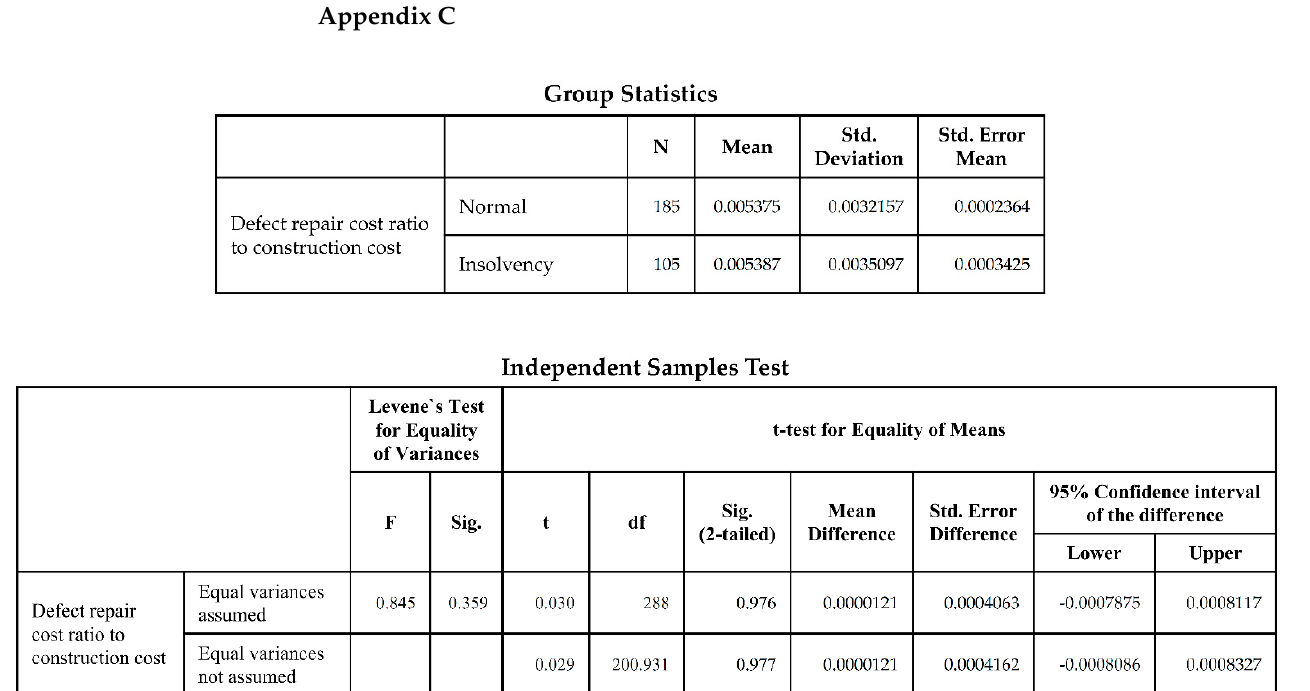
Figure A5. t -test result of building contract. Figure A5. t ‐ test result of building contract. Figure A5. t ‐ test result of building contract.